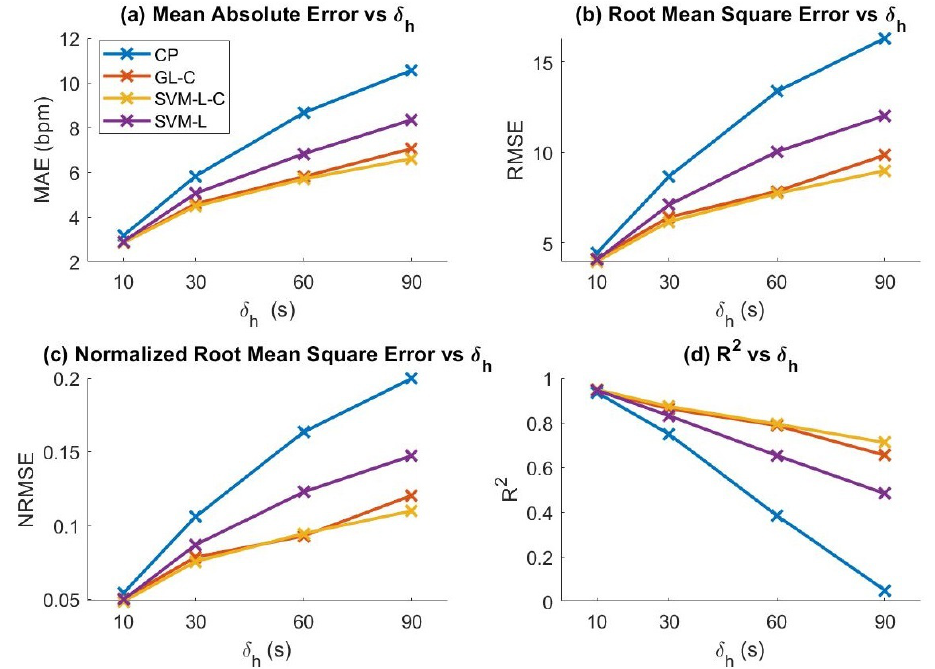
Figure 6. Prediction evaluation metrics of various models for increasing values of HR window history length ( δ h ). Evaluation metrics shown: ( a ) MAE; ( b ) RMSE; ( c ) NRMSE; and ( d ) R 2